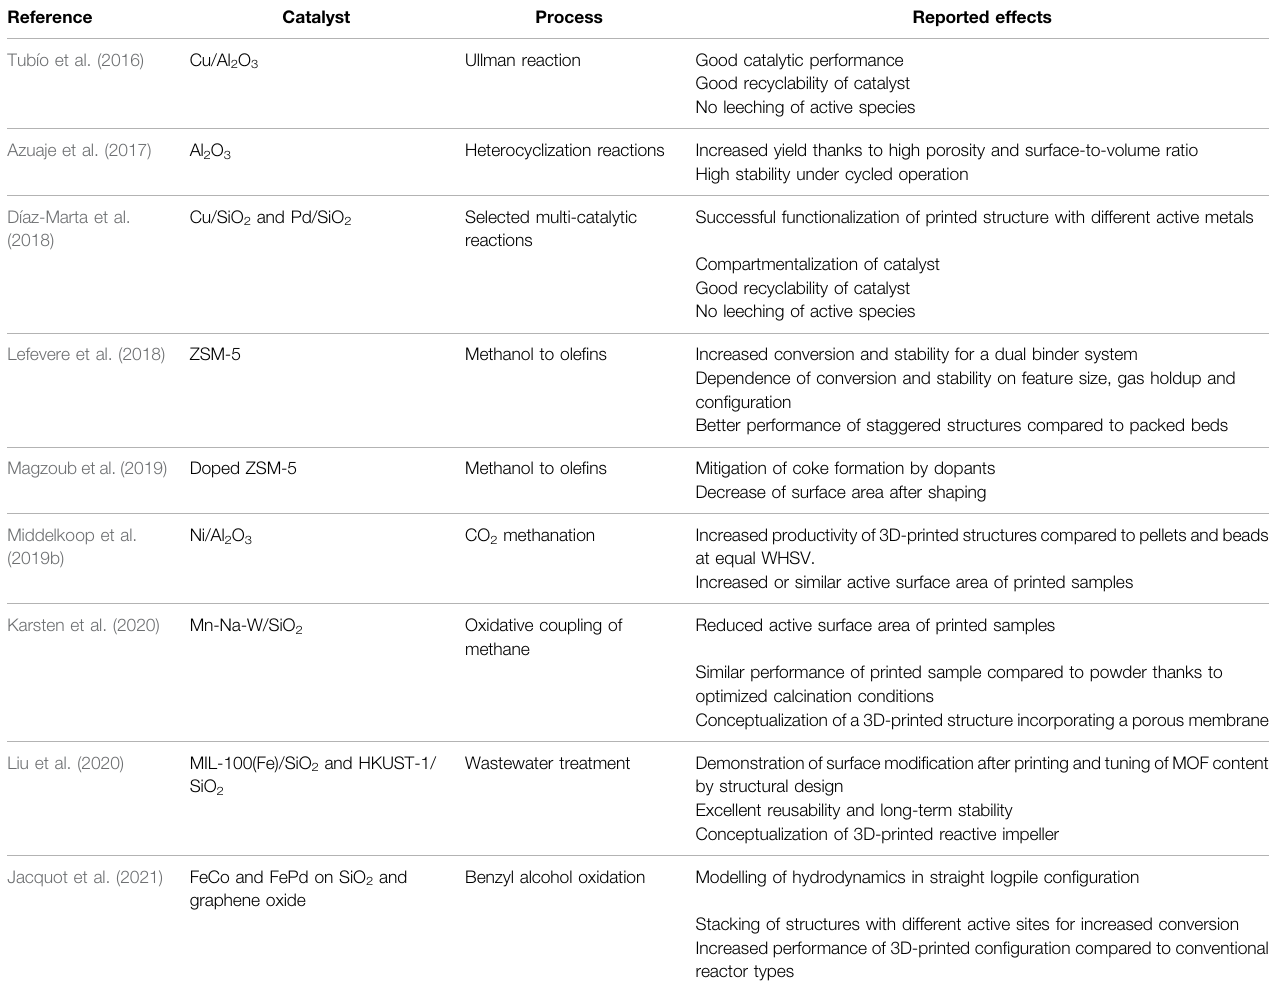
TABLE 1 | Overview of recent literature studies using catalyst logpile structures produced by